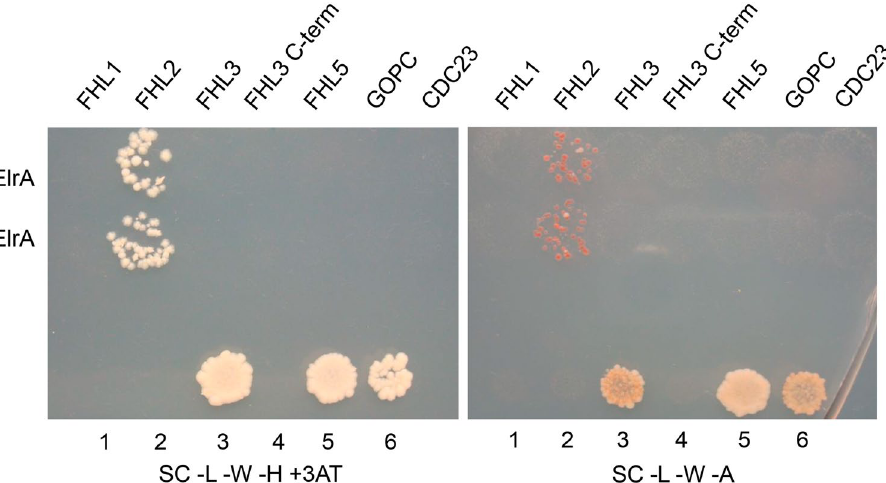
Figure 2. ElrA and FHL family interaction assays. Y2H interaction matrix between ElrA and FHL1 (11050@ D04), FHL2 (31042@A08), FHL3 (11031@C01), a truncated variant of FHL3 containing 1/2 LIM2, LIM3 and LIM4 domains (11018@E03), FHL5 (11050@F02), GOPC (11063@H10) and CDC23 (11088@H06). Mating yeasts were replicated on high stringency selective media i.e ., minimal medium lacking leucine, tryptophan, histidine and containing 5 mM of 3-aminotriazole (SC-L-W-H + 3AT) or minimal medium lacking leucine, tryptophan and adenine (SC-L-W-A). The yeast strains used as controls are carrying the following vectors 1, pPC97-CYH (DB-empty) and pPC86 (AD-empty), 2, DB-RB1 and AD-E2F-1, 3, DB-fos and AD-jun, 4, pPC97 (DB-empty) and pPC86 (AD-empty), 5, DB-DP1 and AD-E2F1, 6, DB-FRM-3 and